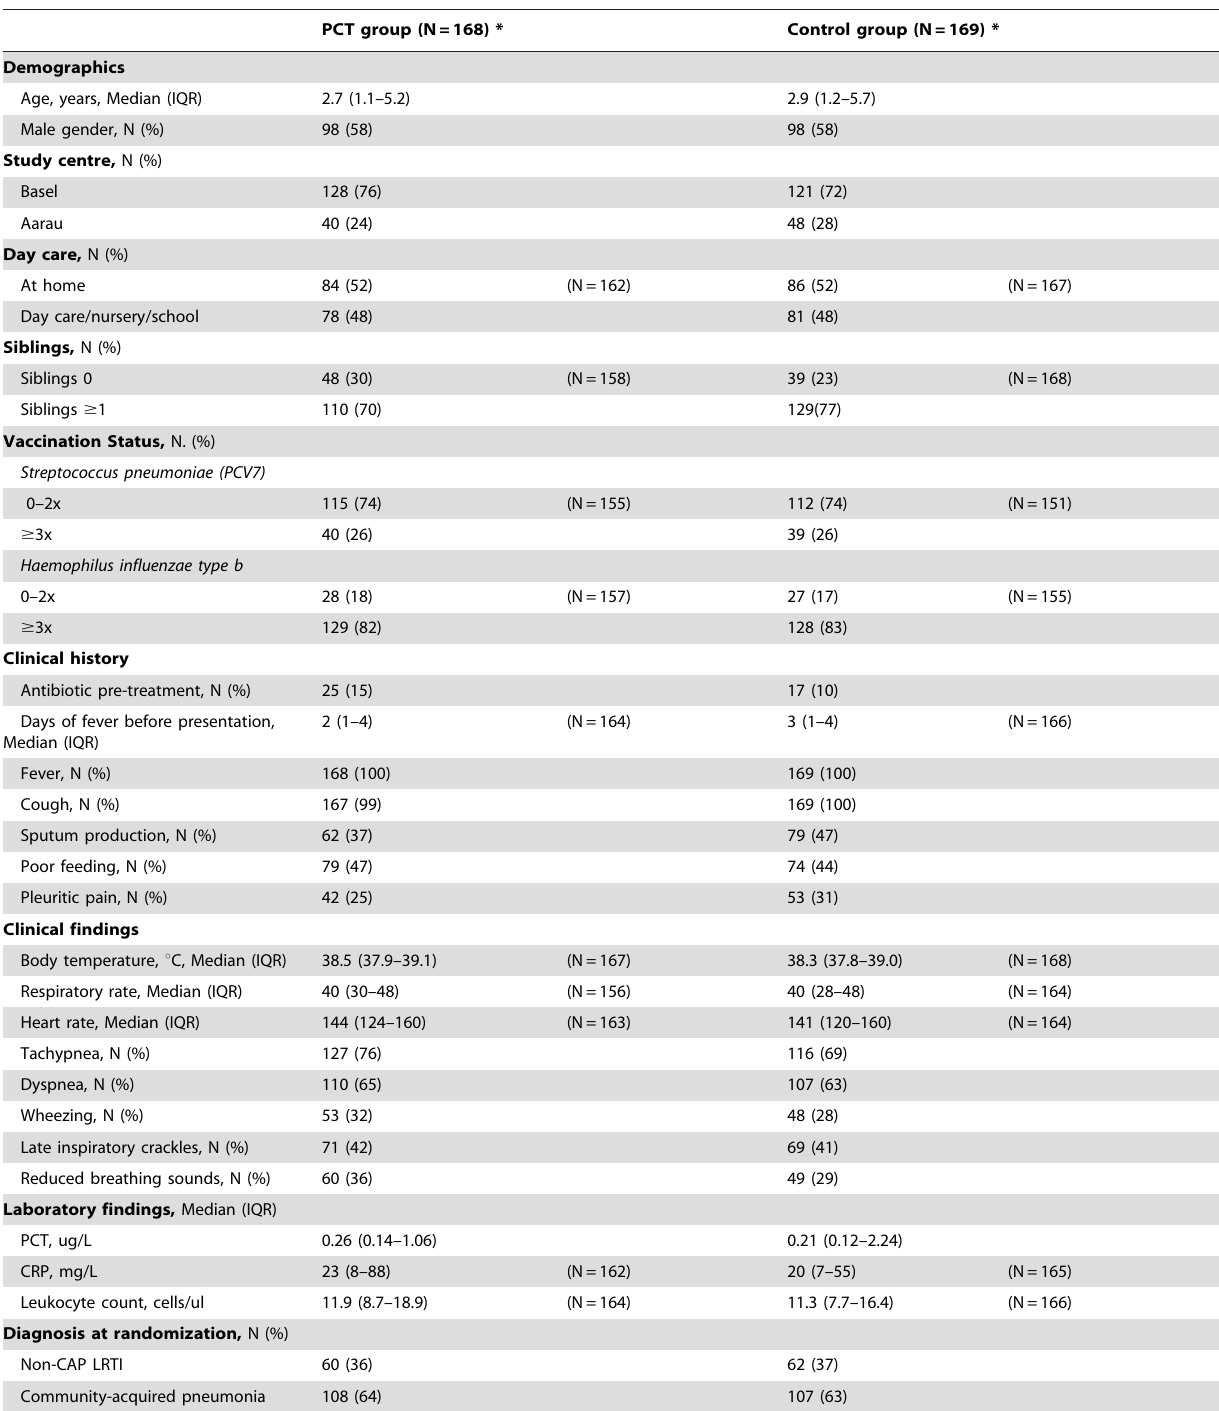
Table 1. Patient baseline